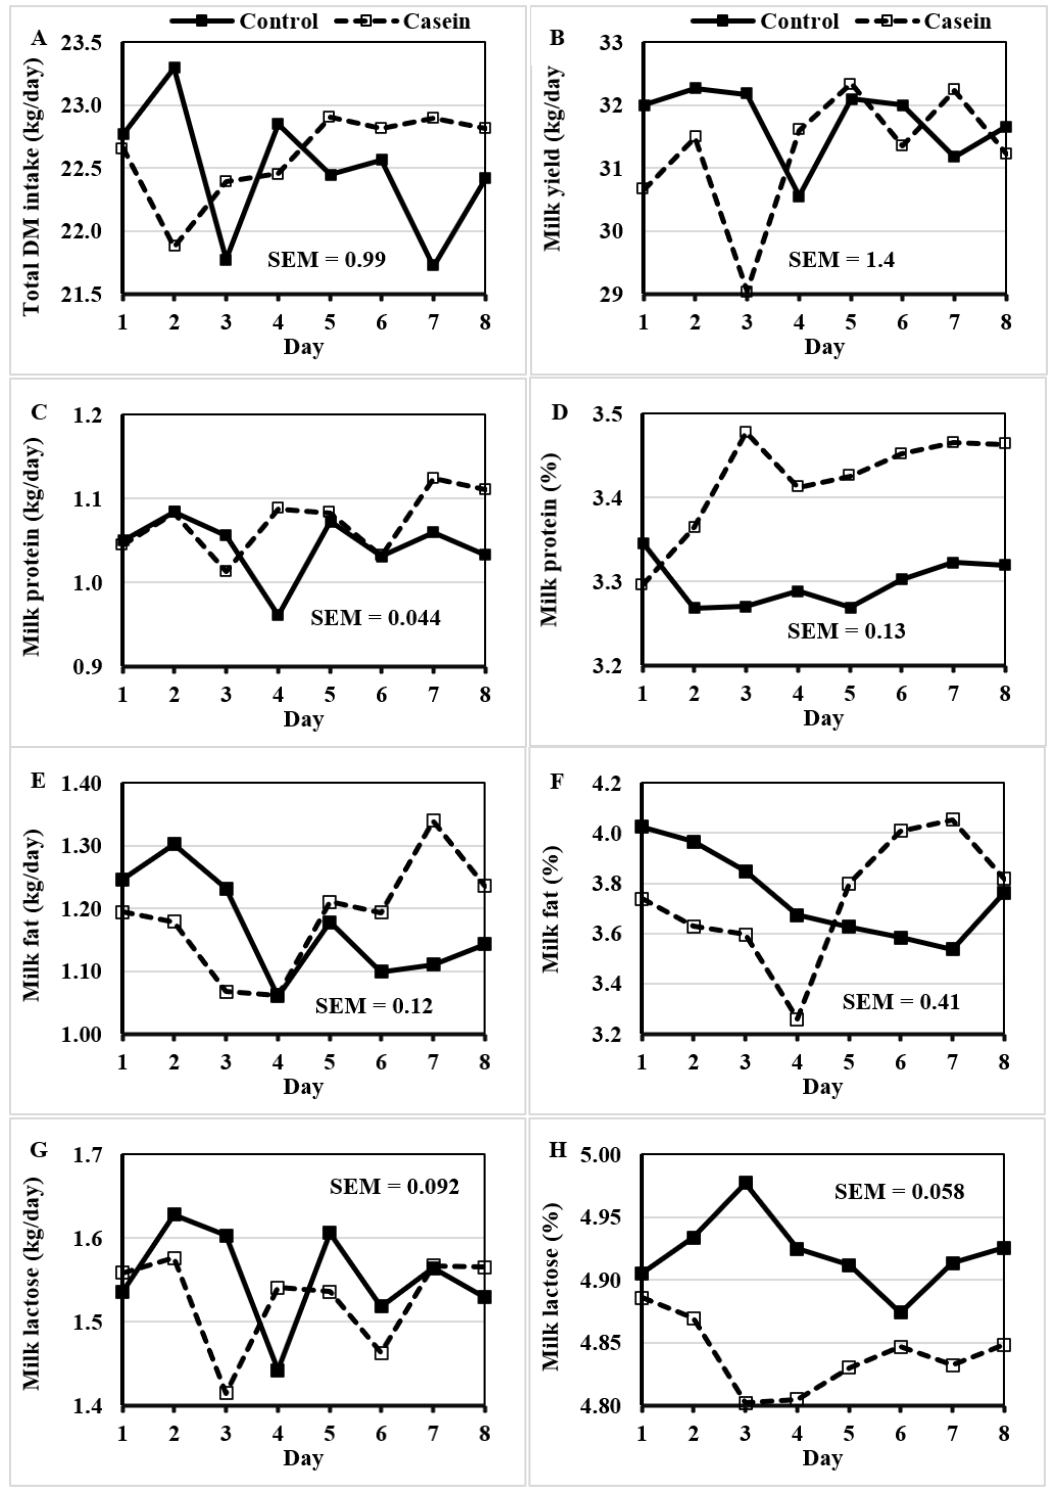
Figure 2. Effect of casein supplementation on dry matter intake, milk production, milk composition, and milk component yields from days 1 through 8 of each period. ( A ) total dry matter (DM) intake: casein, p = 0.77; casein × day, p = 0.33. ( B ) milk yield: casein, p = 0.32; casein × day, p = 0.73. ( C ) milk protein yield: casein, p = 0.08; casein × day, p = 0.75. ( D ) milk protein content: casein, p < 0.001; casein × day, p = 0.32. ( E ) milk fat yield: casein, p = 0.90; casein × day, p = 0.71. ( F ) milk fat content: casein, p = 0.97; casein × day, p = 0.92. ( G ) milk lactose yield: casein, p = 0.49; casein × day, p = 0.76. ( H ) milk lactose content: casein, p < 0.001; casein × day, p =